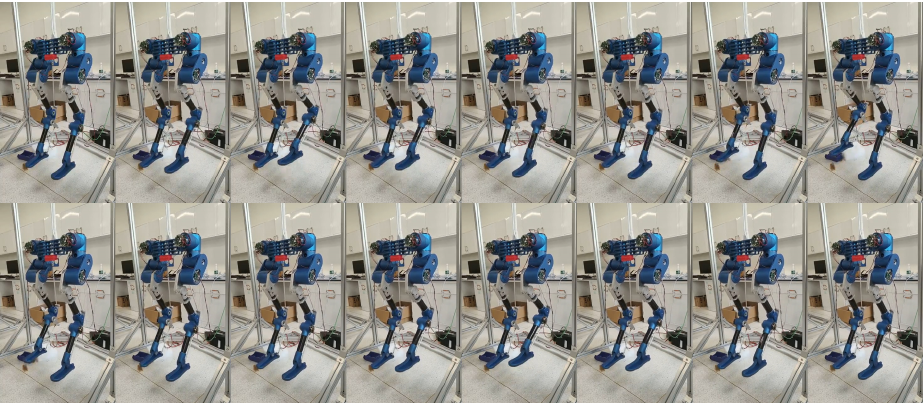
Figure 10. The prototype walks step in the